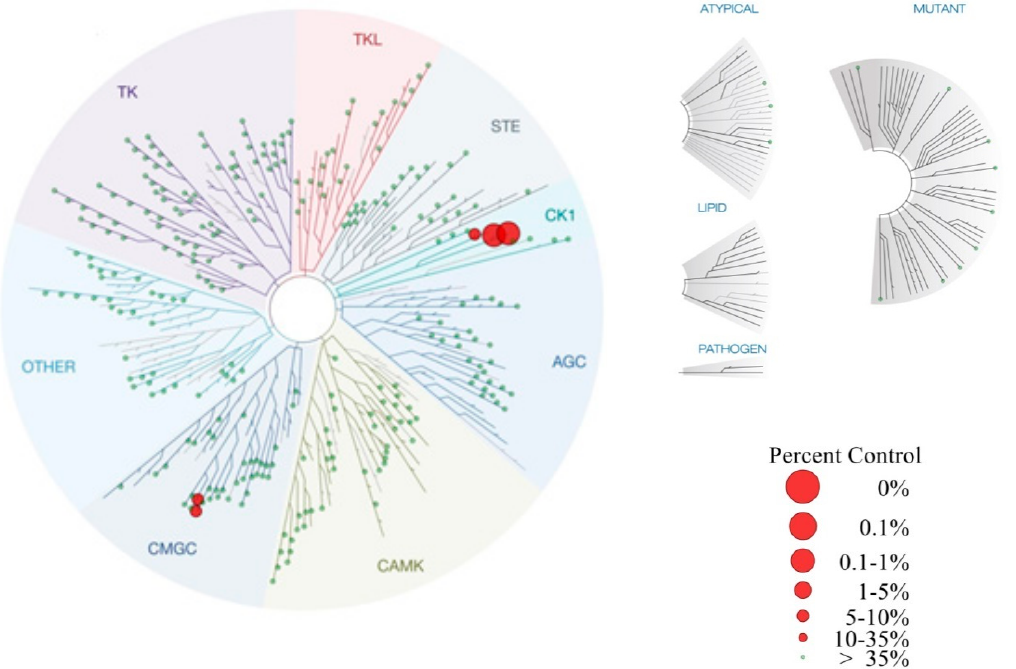
Figure 5. Dendrogram representation of the selectivity profile of 29d at a concentration of 1 µ M in a panel of 320 wild-type kinases (ProQinase, Freiburg, Germany). The residual kinase activity was determined compared to DMSO control. Images were generated using TREEspot Software Tool, DISCOVERX CORPORATION 2010. The complete raw data are shown in Table S2.